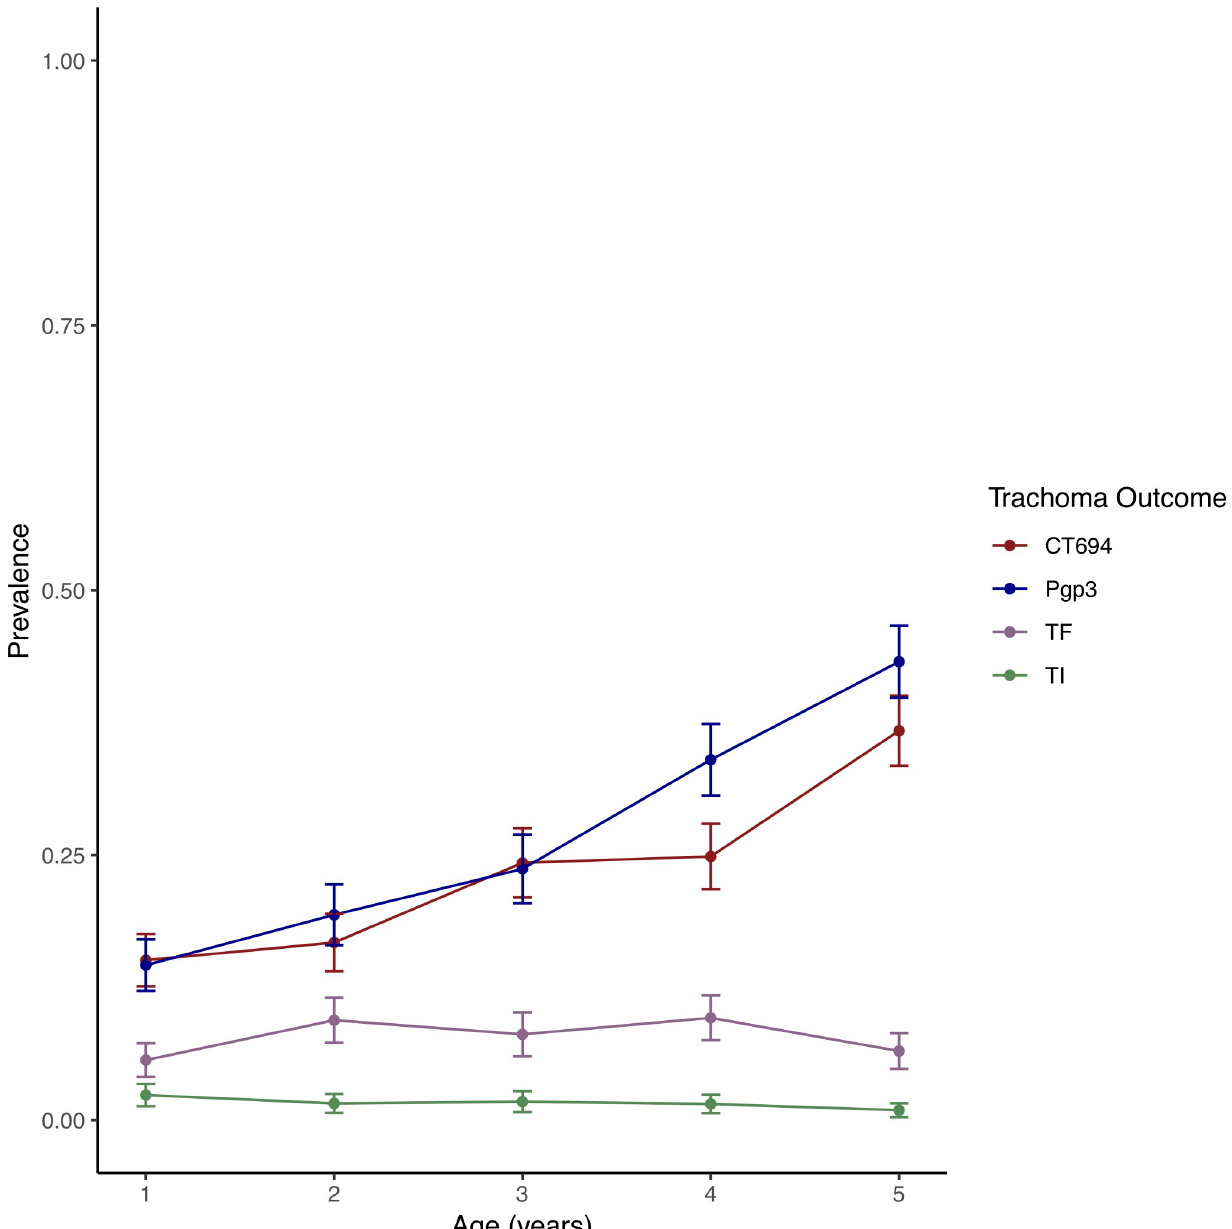
Fig 2. Prevalence of antibodies recognizing Pgp3 (blue) and CT694 (red), trachomatous inflammation—follicular (TF, purple) and trachomatous inflammation—intense (TI, green) by age in years.